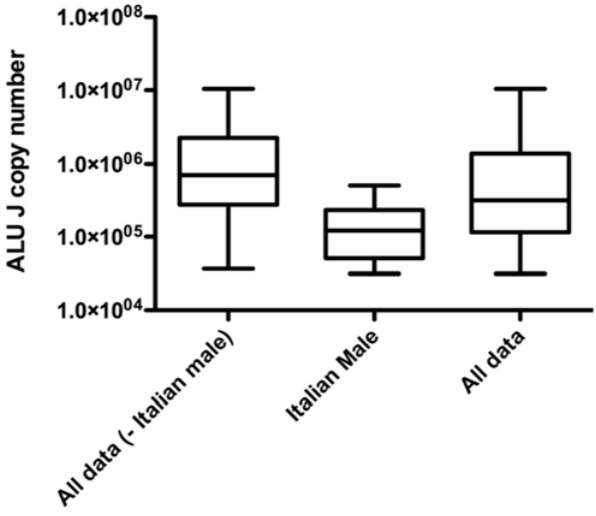
Figure 2. Baseline (day 0) ALU J DNA sequences are log normally distributed. Italian male data contains less human DNA compared to females but still falls within the range of the all other baseline data. The data remain log normally distributed when both sites and sexes are combined. Box and whisker plots showing median, 25 th and 75 th percentiles and